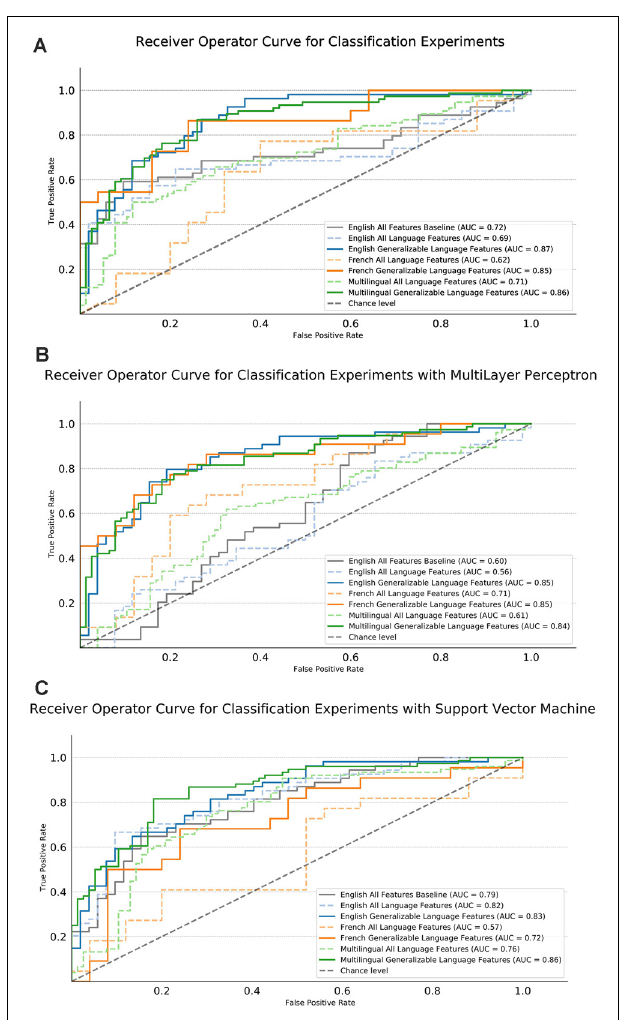
FIGURE 4 | Area Under Curve (AUC) performance results of the machine learning (ML) experiments. English and French for the respective samples separately, multilingual is for the joint classification, multilingual significance testing for feature selection (Generalizable) or using all features (ALL) and using only semantic, syntactic, and paralinguistic features (Language Features). The gray dashed line indicates chance performance of the models. The English (blue), French (orange), and Both (green) models trained with semantic, syntactic, and paralinguistic features are shown with a dashed line. The English, French and Multilingual models trained with the significant, generalizable features in English and French are indicated by the solid lines in the same color,